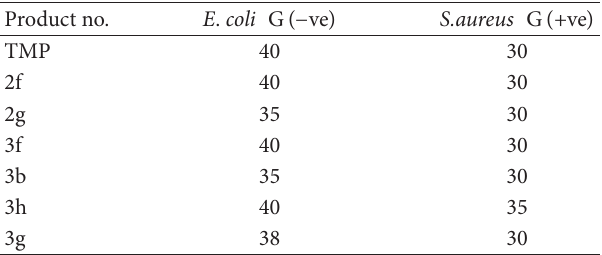
T 1: Antibacterial activity of some prepared imines and thiazolidin-4-ones with inhibition zone diameters in (mm) scale against S.aureus and E.coli